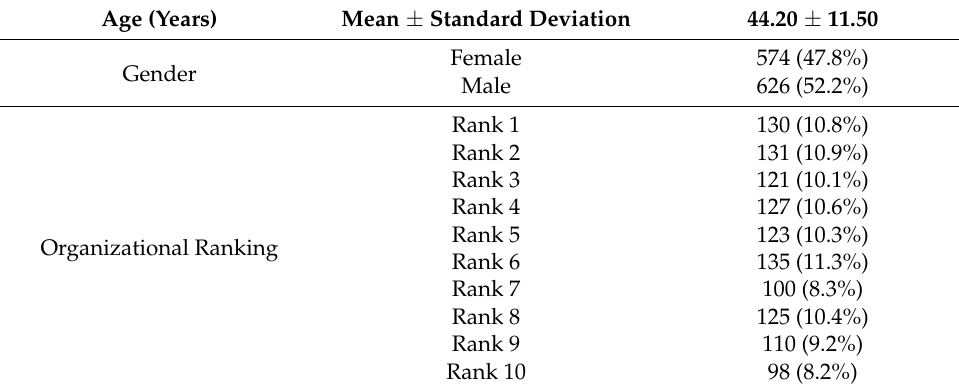
Table 1. Sociodemographic data of the participants.